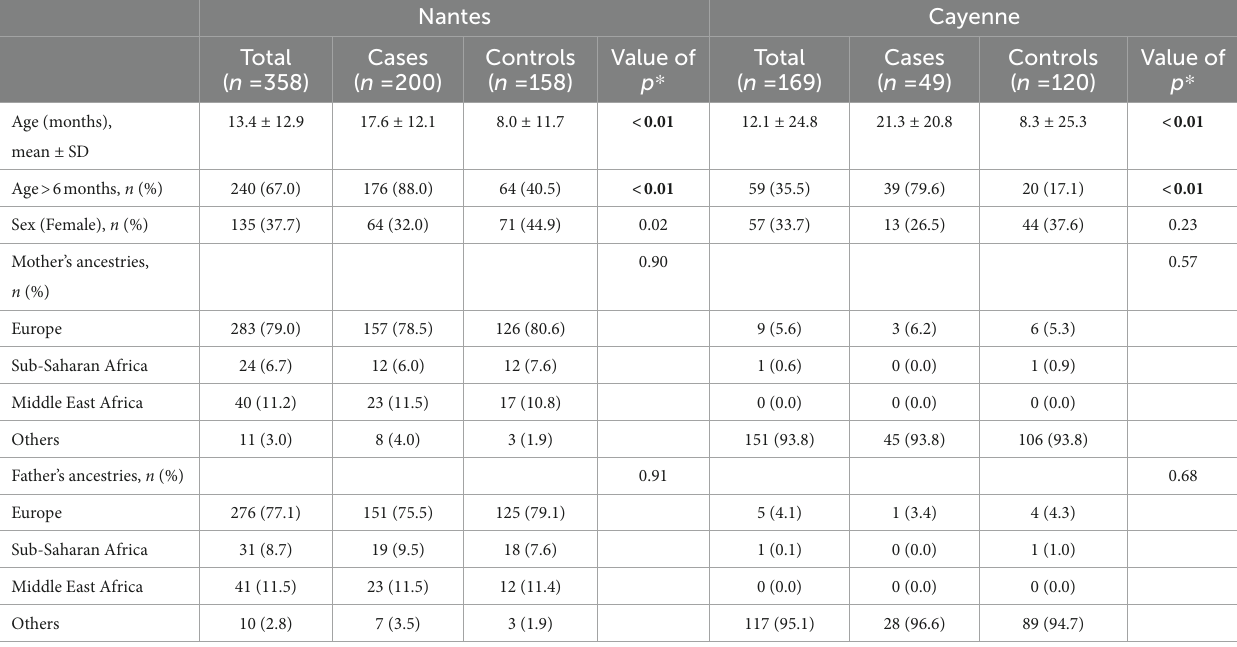
TABLE 1 Description of cases and controls in Nantes and